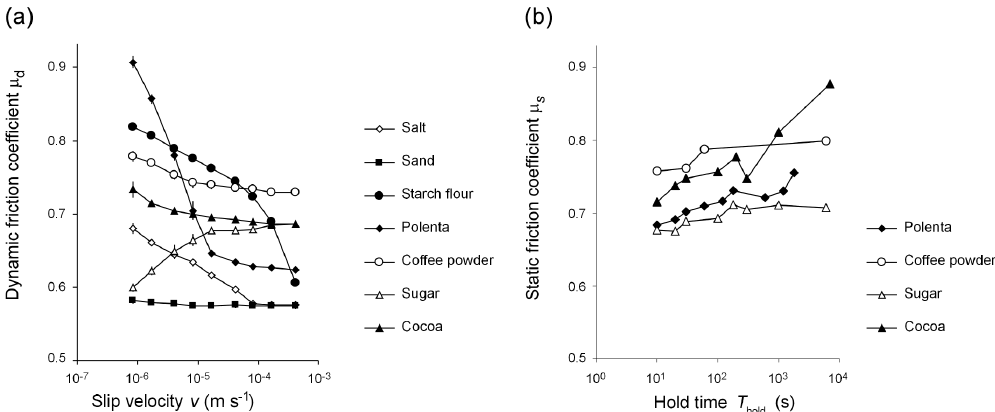
Figure 9. Rate and state effects on friction of selected analogue rock materials: (a) rate effect ( v strengthening versus v weakening) from velocity stepping tests, (b) state effect (healing) from slide–hold–slide tests. Results from tests using a Schulze ring-shear tester RST-01 (Schulze, 1994; Fig. 2b). Data and methodological details are published as open-access material in Rosenau et al. (2016).